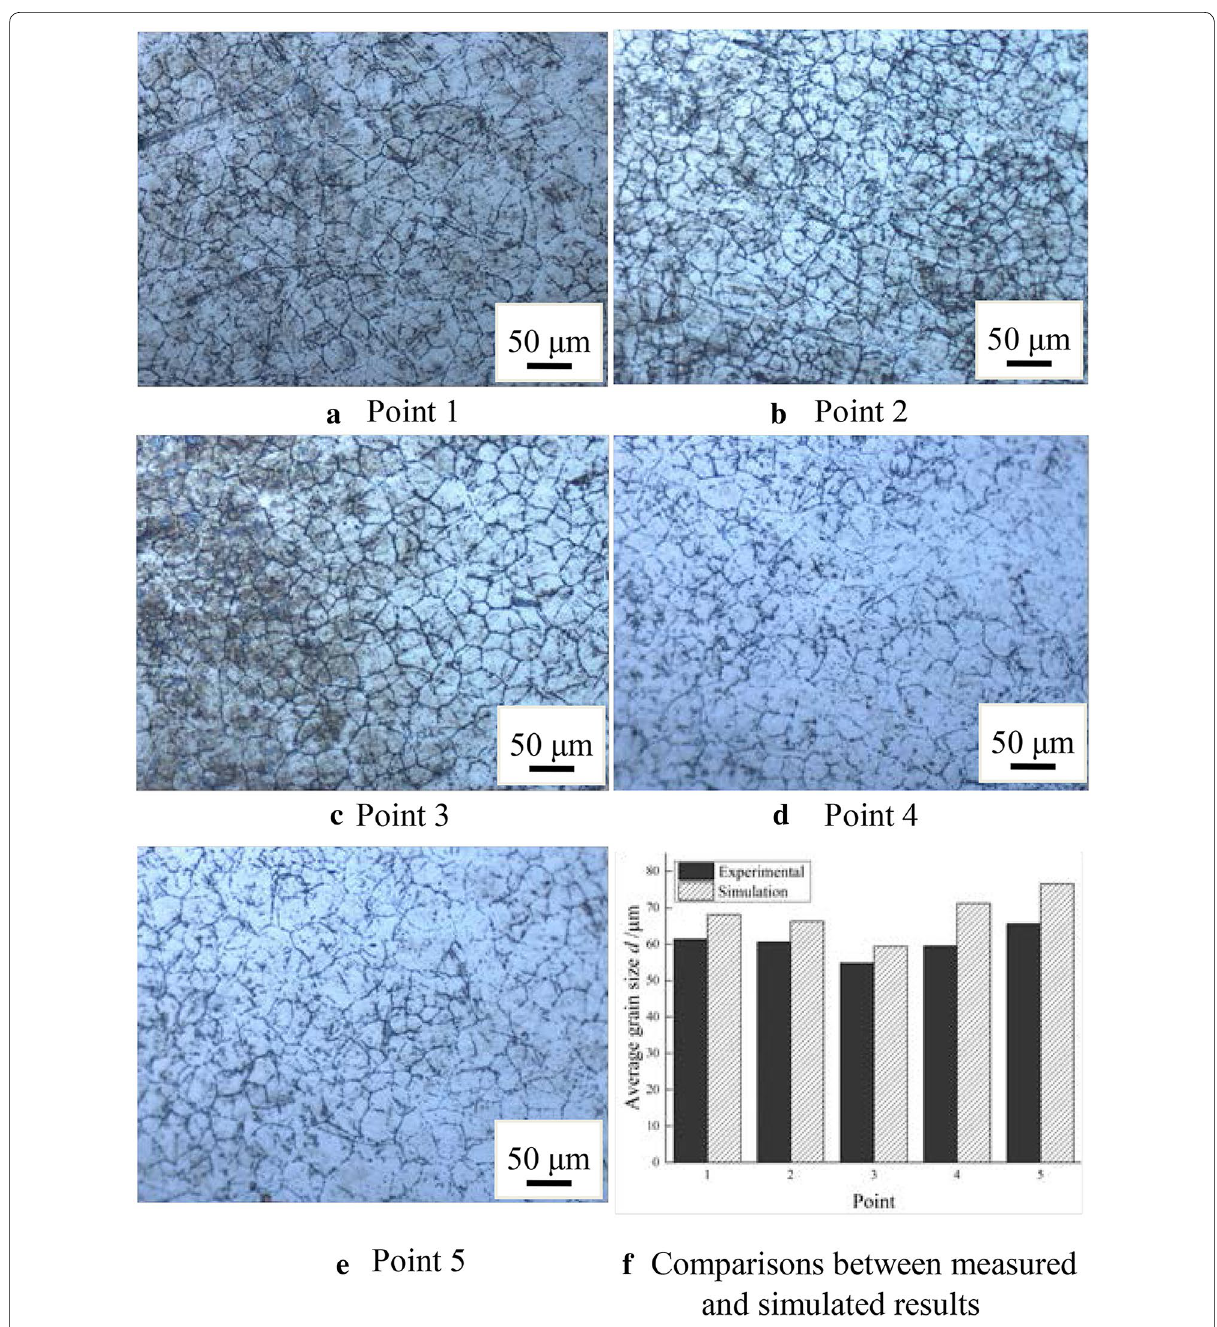
Figure 16 The metallographic structures of extruded pipe and the grain sizes comparisons between measured and simulated